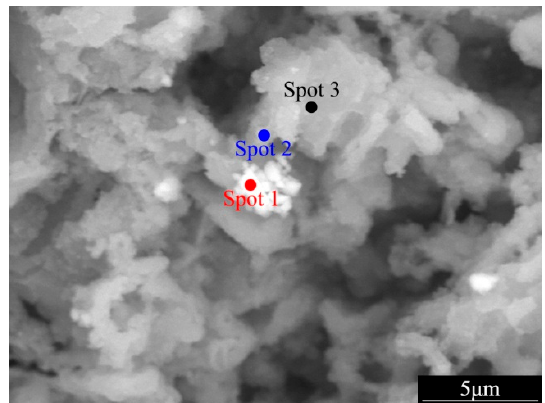
Figure 5. The EDS image (backscatter electron) of YAl 2p /LA143 composites’ surface after 72 h immersion in 3.5 wt.% NaCl solution. Table 1. The weight percentage of element for spot scanning in Figure 5.